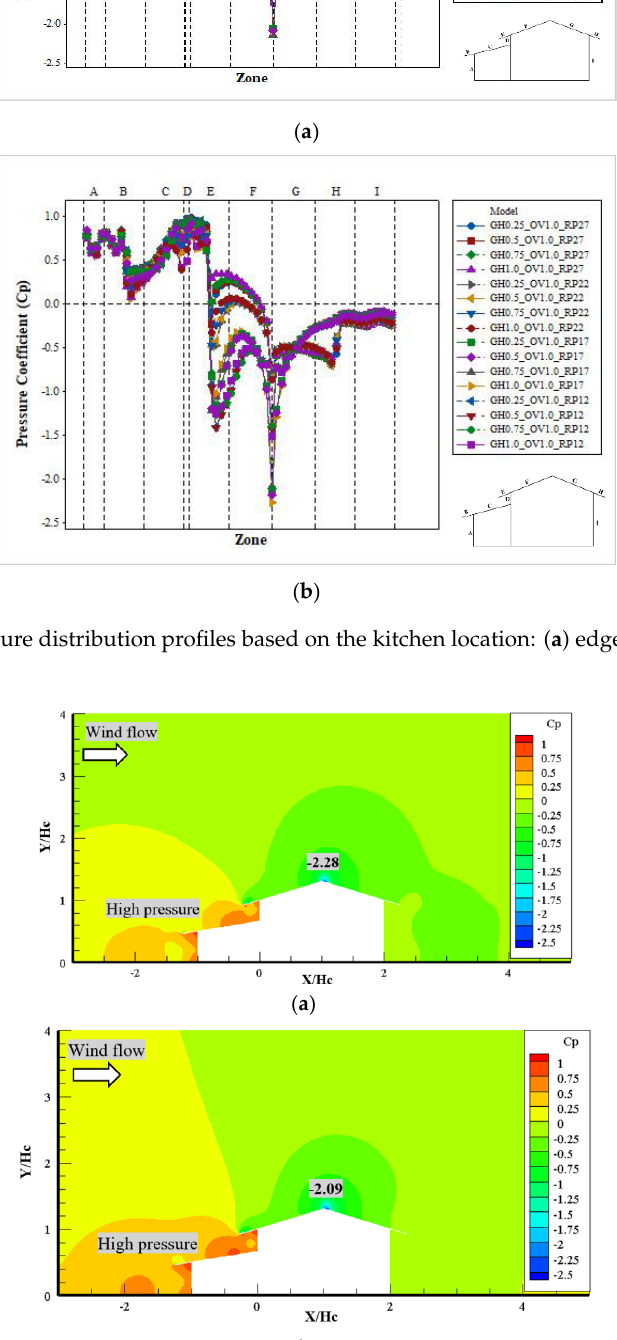
Figure 13. Pressure contours along the transverse profile of the house model with the kitchen at the ( a ) center and ( b ) edge. ( a ) center and ( b )